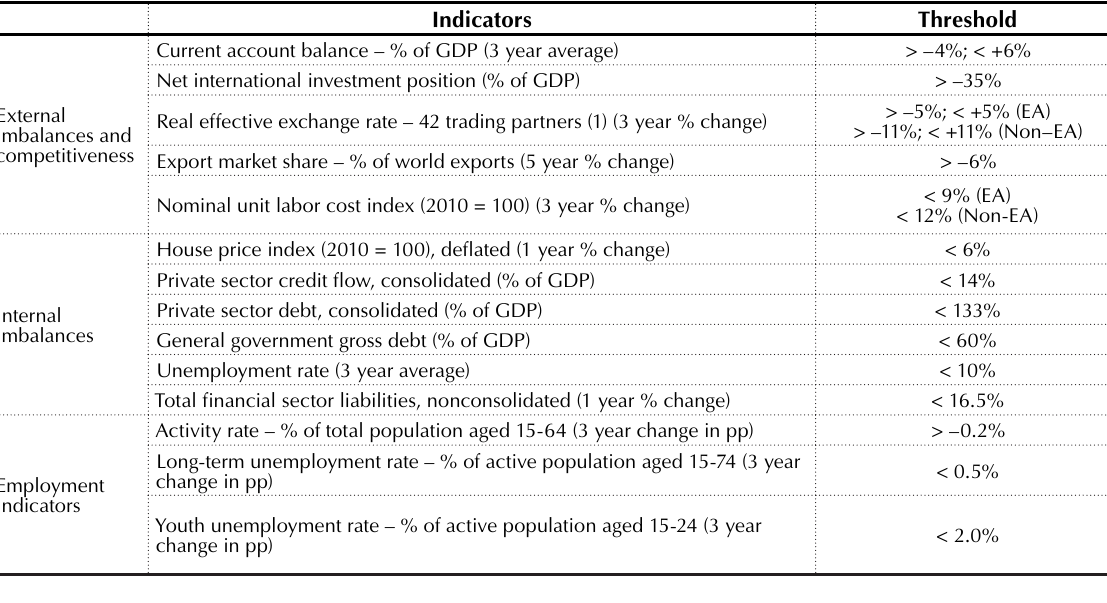
Table 1. Macroeconomic Imbalance Procedure